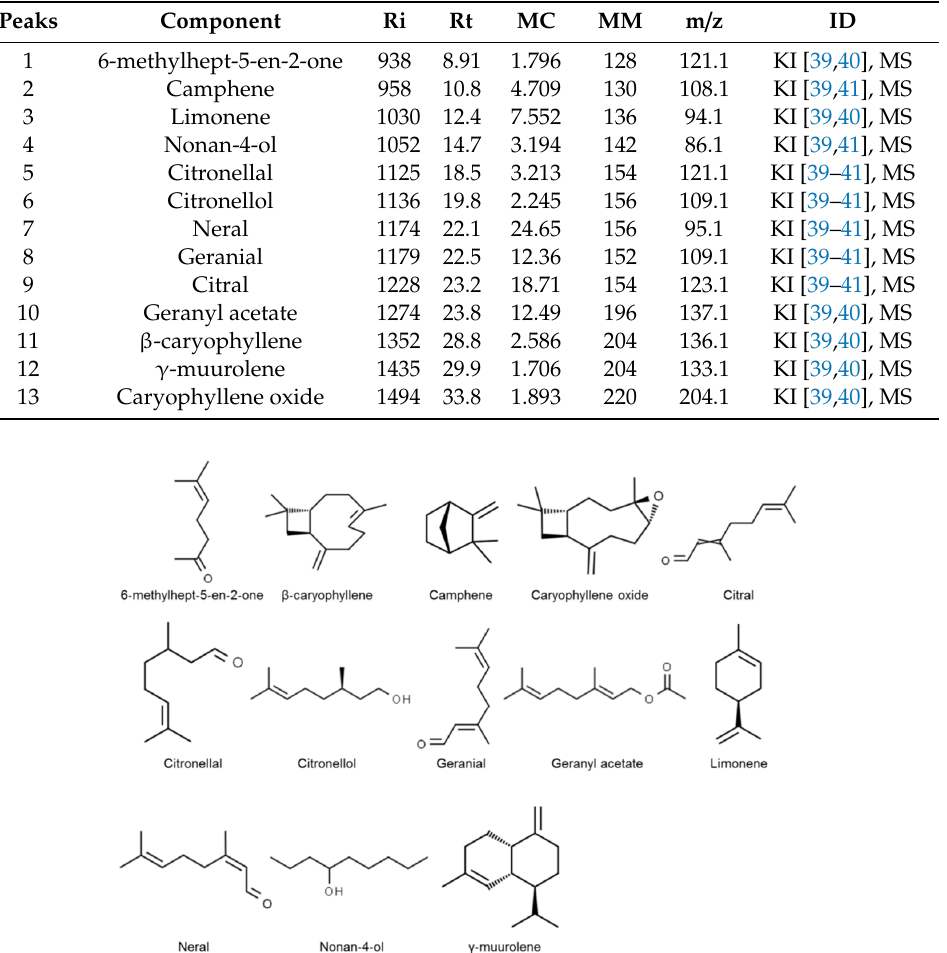
Figure 2. Chemical structure of main components identified in the lemongrass essential oil.